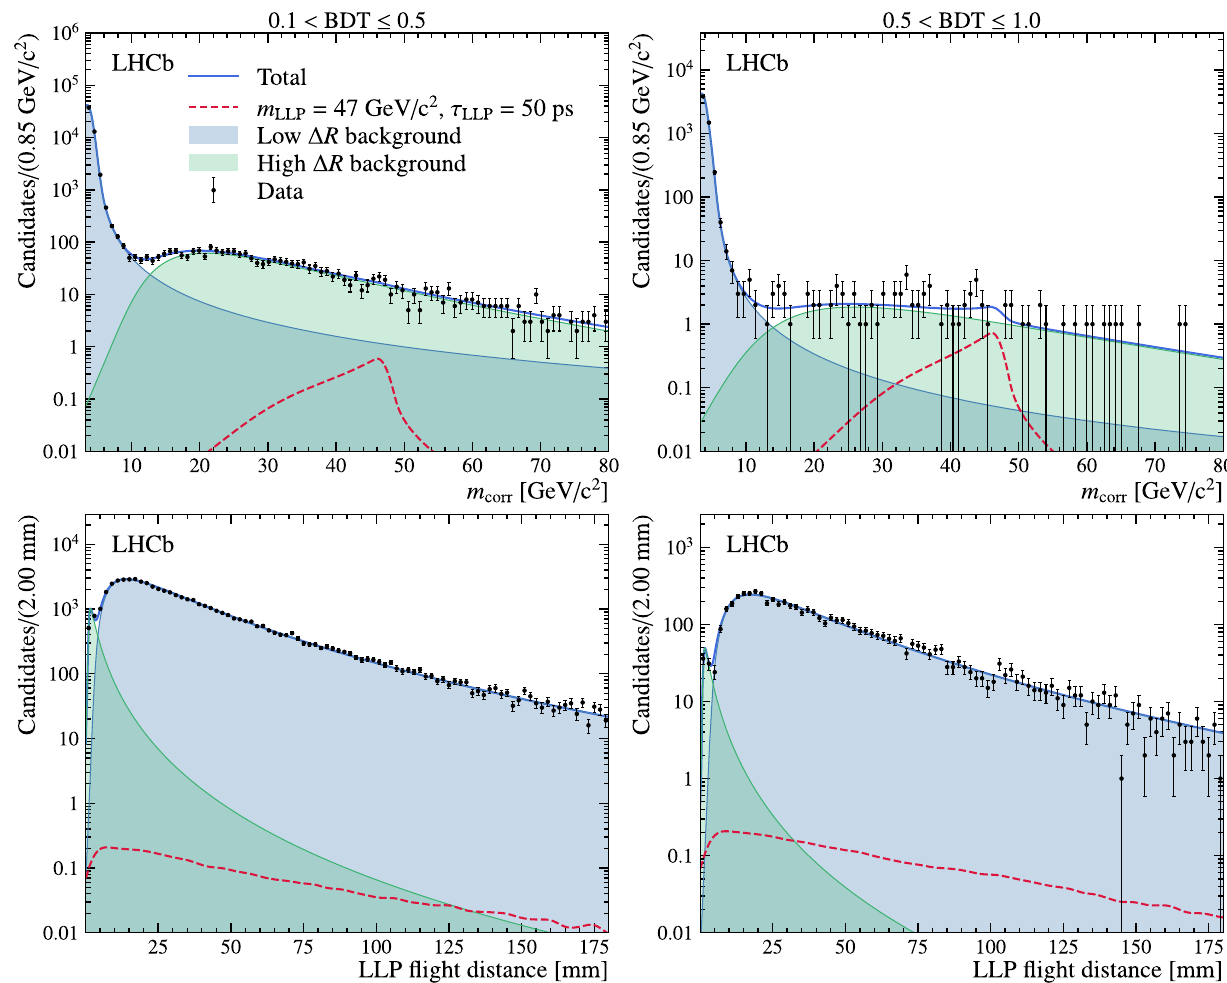
Fig. 4 Distributions of m corr (top) and the flight distance (bottom) of two BDT intervals (left and right), where a simultaneous fit result for a LLP signal with m LLP = 47GeV/ c 2 and τ LLP = 50ps is overlaid; the fitted signal yield in this example is 14 ± 14